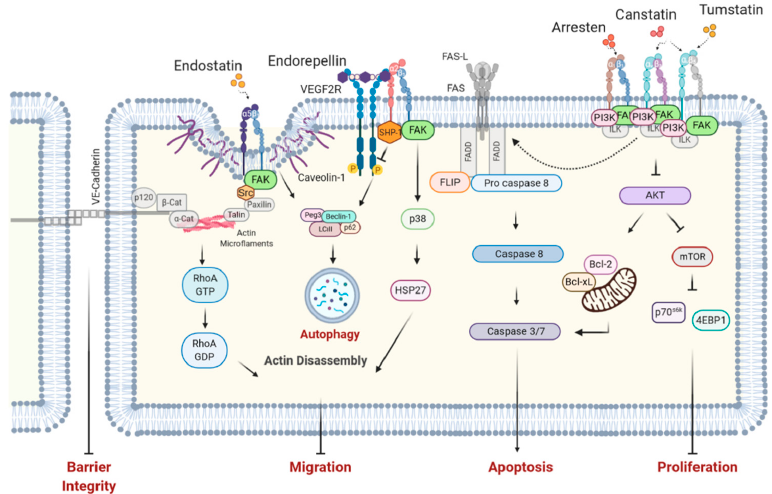
Figure 1. Possible mode of action of matrikines on pulmonary arterial endothelial cells. Type IV collagen matrikines alter cell survival in endothelial cells. Arresten and canstatin activate Fas-L- mediated apoptosis (caspase 8 activation) via an unknown mechanism [154,155]. Upon integrin binding, arresten, canstatin, and tumstatin induce caspase-9 dependent mitochondrial apoptosis via